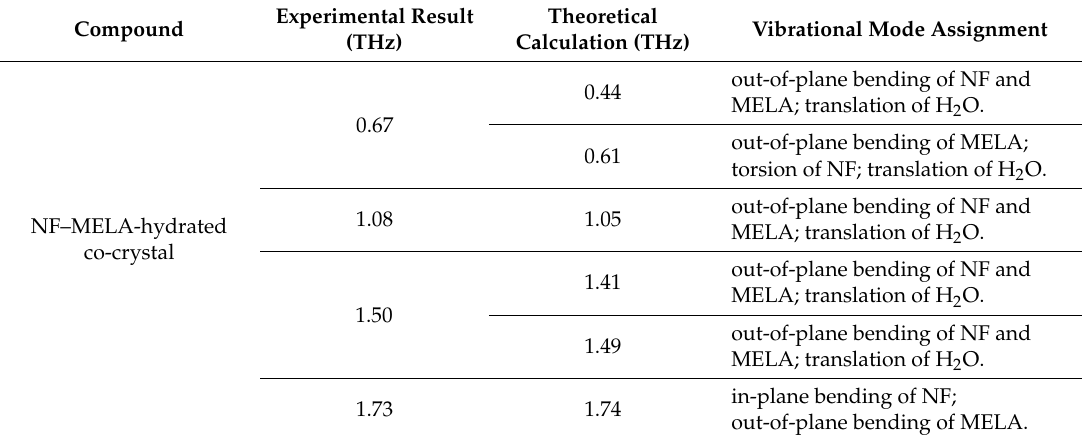
Table 1. Description of the vibrational modes of the NF–MELA-hydrated co-crystal in its THz spectrum. Experimental Result Compound (THz)